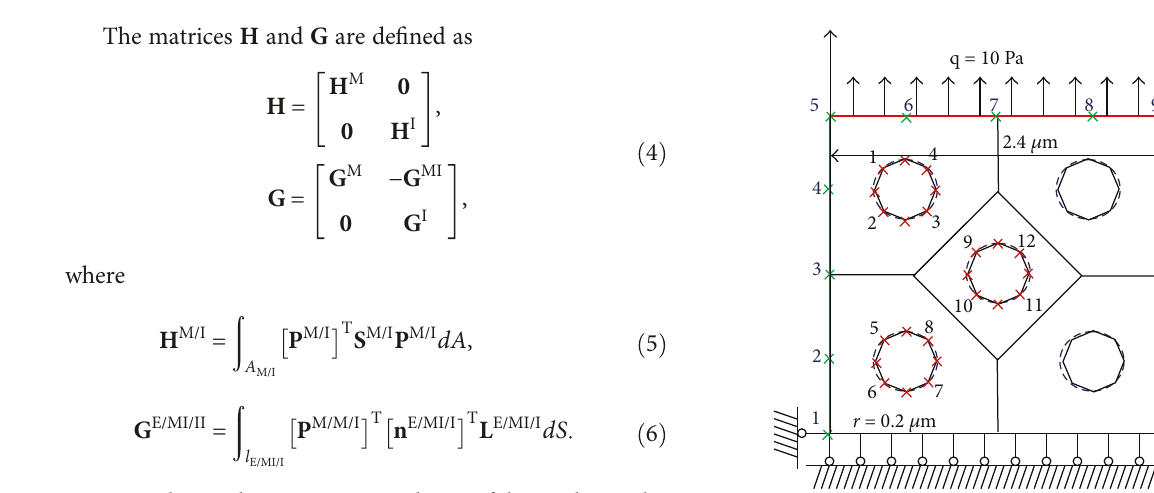
Figure 4: RVE model with fi ve